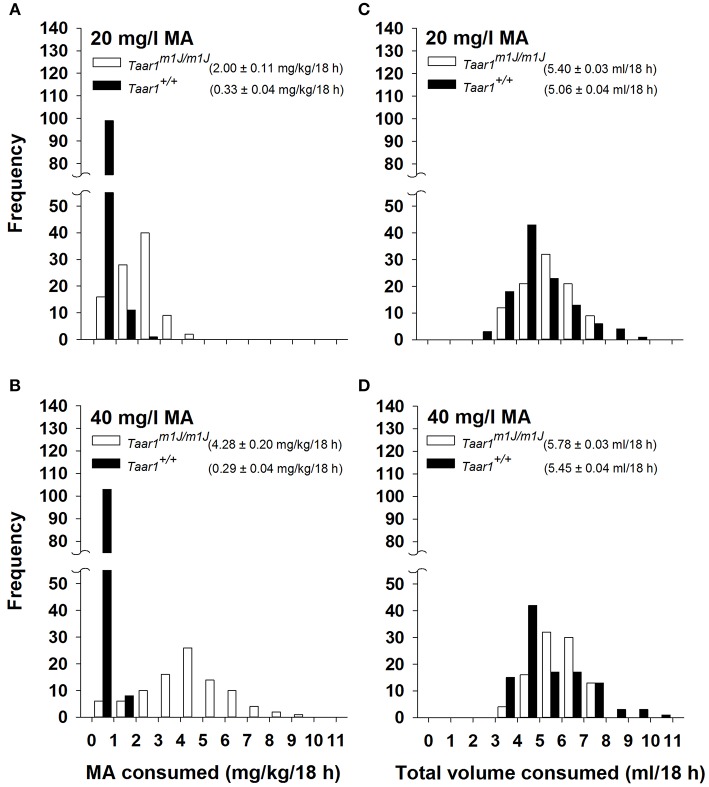
Frequency distributions for (A) 20 mg/l MA consumed, (B) 40 mg/l MA consumed, (C) total volume consumed during 20 mg/l MA access, and (D) total volume consumed during 40 mg/l MA access in 206 BXD RI mice, according to Taar1 genotype. Mean ± SEM MA or total volume consumed is given in the legend for each Taar1 genotype.